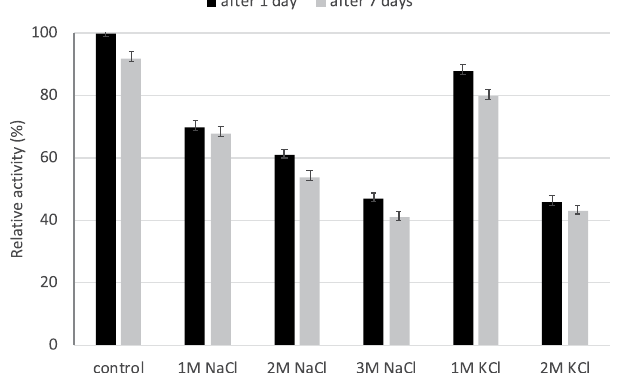
Figure 3. Stability of VbTA T16F at different salt concentrations. Data are reported as relative percentage activity in comparison with the control in standard conditions. Results are reported as the average of triplicate